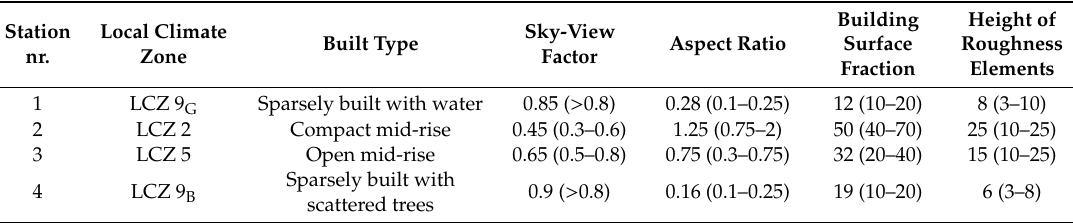
Table 1. Classification of the Local Climatic Zone (LCZ) for each station. In parentheses are limits for each parameter according to Stewart and Oke (2012) [38]. Station nr.